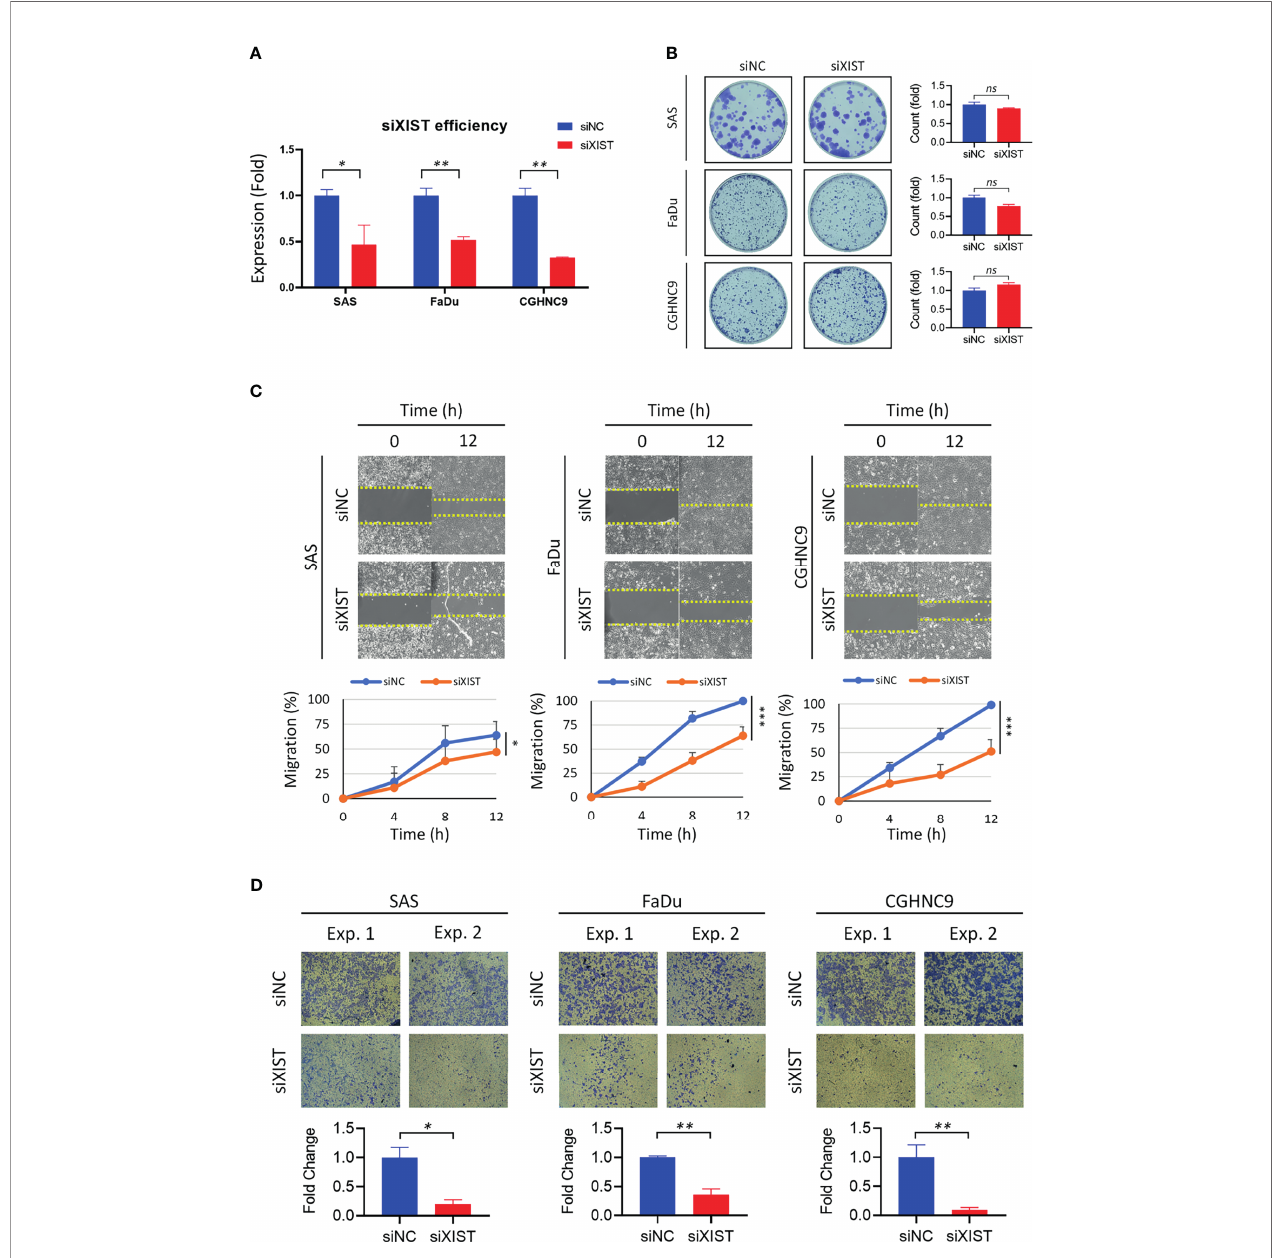
FIGURE 7 | Validation and functional analysis of XIST as an HNC panel biomarker. (A) siRNA ef fi ciency of XIST silencing was examined with RT-qPCR. Optimal knockdown was achieved by transfection in SAS, FaDu, and CGHNC9 cell lines. (B) Colony formation ability was determined after successful silencing of XIST. No signi fi cant difference was observed between the three cancer cell lines when compared to the normal keratinocytes. (C) The wound-healing model was used for migration assay. SAS was partially inhibited by roughly 20%, while FaDu and CGHNC9 was inhibited by at least 60%. (D) Invasion ability was determined via Matrigel invasion assay. All three cell lines showed statistically signi fi cant inhibition rates in the XIST knockdown group. All functional experiments were performed in triplicates. (***p ≤ 0.001, **p ≤ 0.01, *p ≤ 0.05, t-test, ns = not signi fi